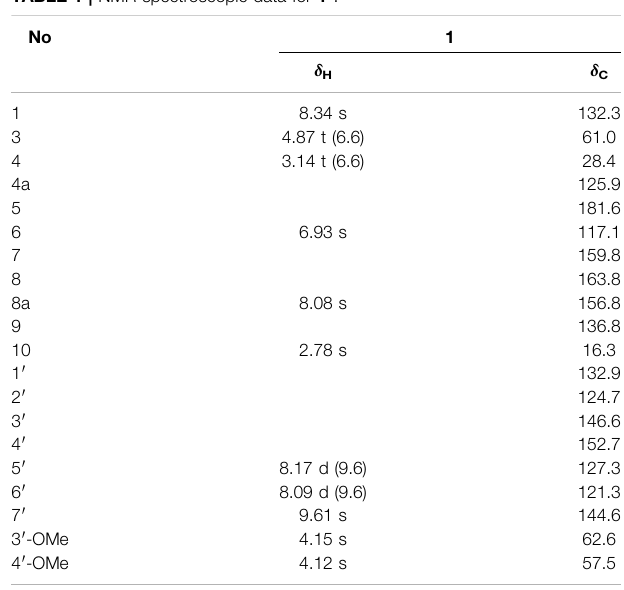
TABLE 1 | NMR spectroscopic data for 1 a